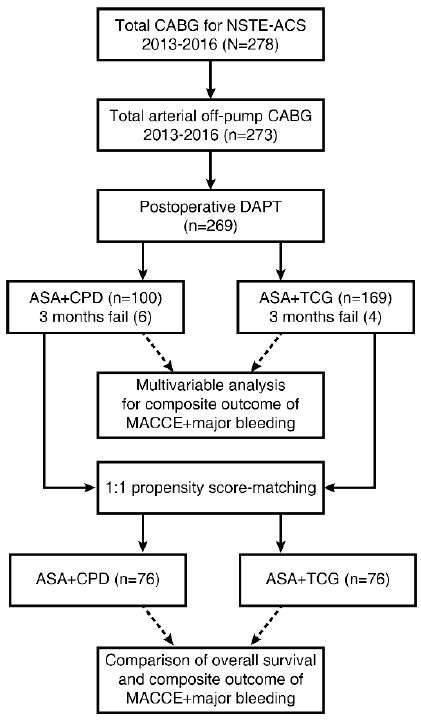
Figure 1. Flow diagram of the study design and analyses. ASA, acetylsalicylic acid; CABG, coronary artery bypass grafting; CPD, clopidogrel; DAPT, dual antiplatelet therapy; MACCE, major adverse cerebrovascular and cardiovascular event; TCG, ticagrelor.